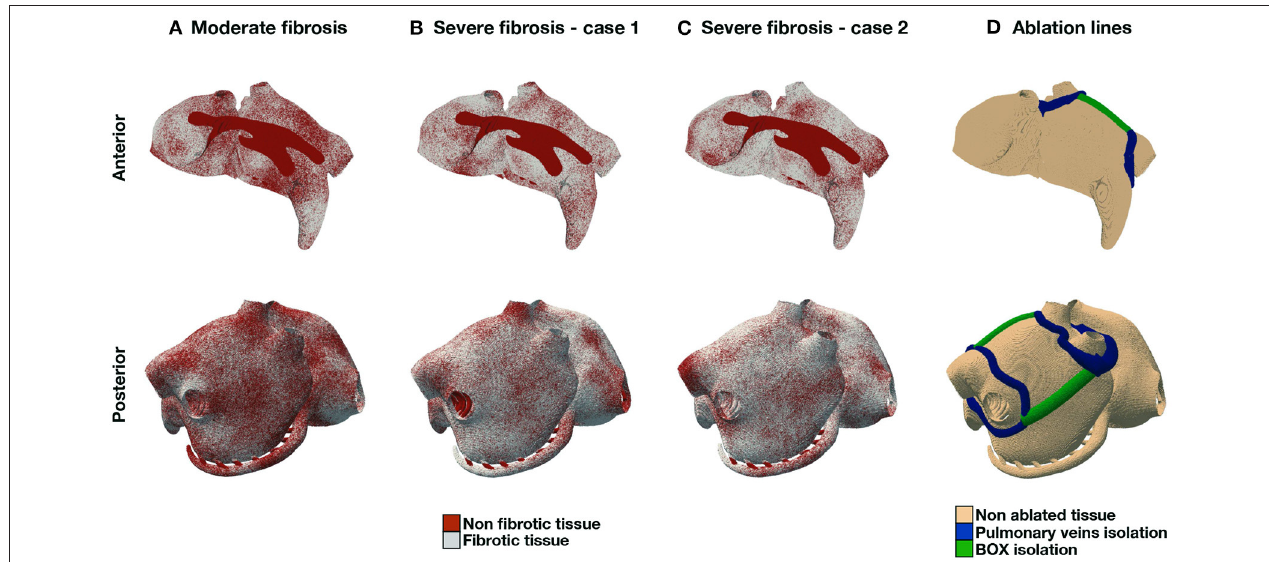
FIGURE 2 | AF models. Fibrosis distribution in 3 different scenarios: moderate fibrosis [ (A) , 50% fibrotic tissue], and severe fibrosis (70%) in two different patterns (B), (C) . (D) shows PVI and BOX ablation